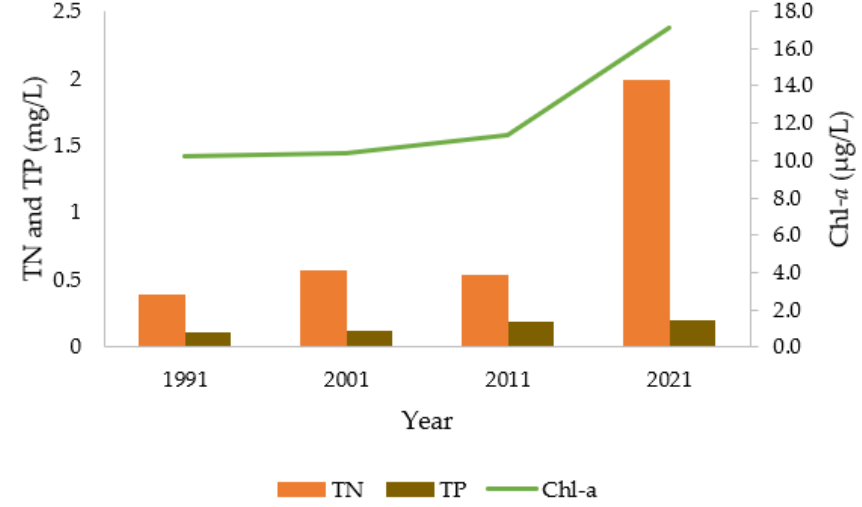
Figure 9. Trend of TN, TP and Chl- a from 1991 to 2021 in Lake Kyoga. Table 5. Correlation between LULC classes and fish catches in Lake Kyoga catchment. Water Wetlands Settlement Agric–Land Rangelands